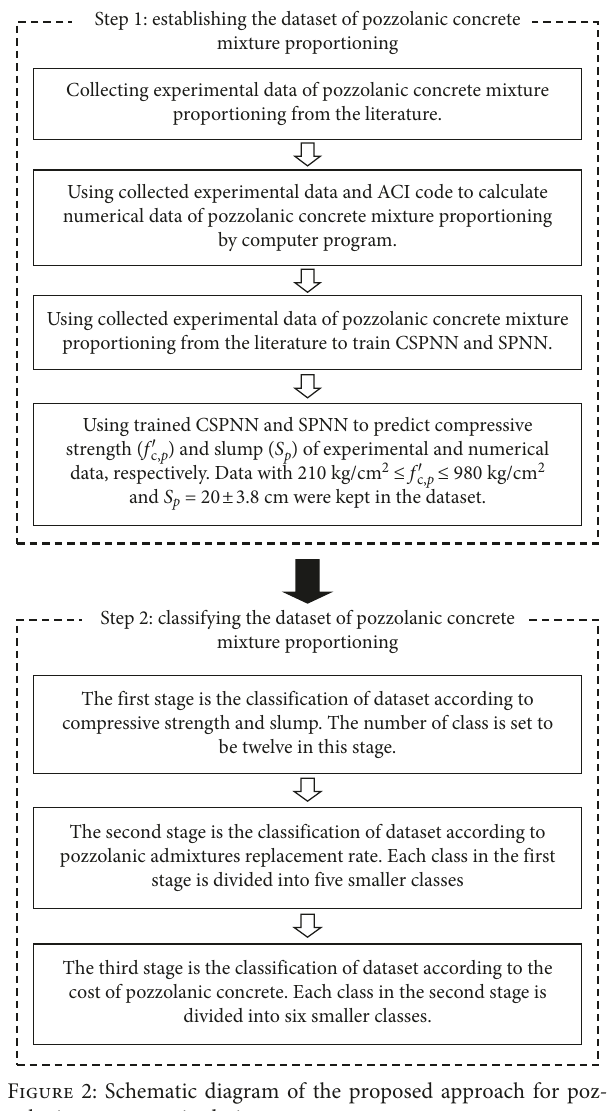
Figure 2: Schematic diagram of the proposed approach for poz- zolanic concrete mix